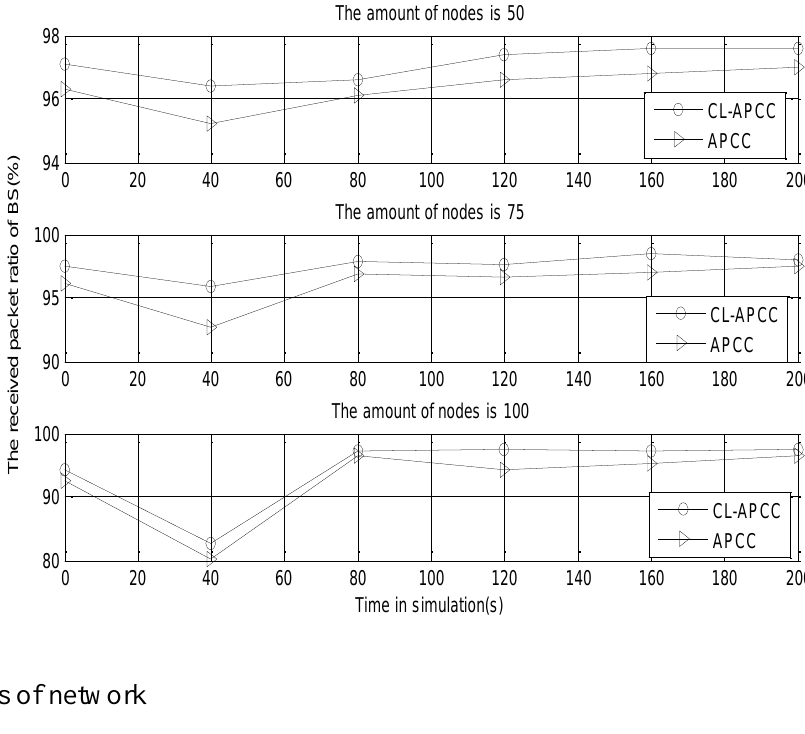
Figure 16. The impact of revised IEEE 802.11 protocol for the RPR of the network.